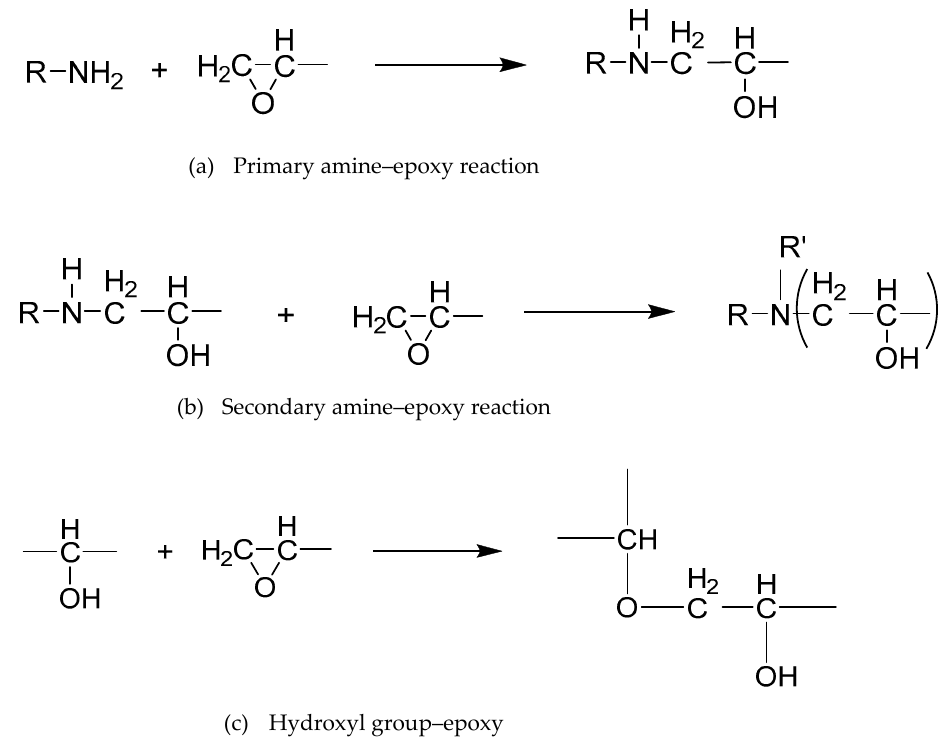
Figure 2. Amine–epoxy reactions ( a, b ) and hydroxyl–epoxy reaction ( c ).